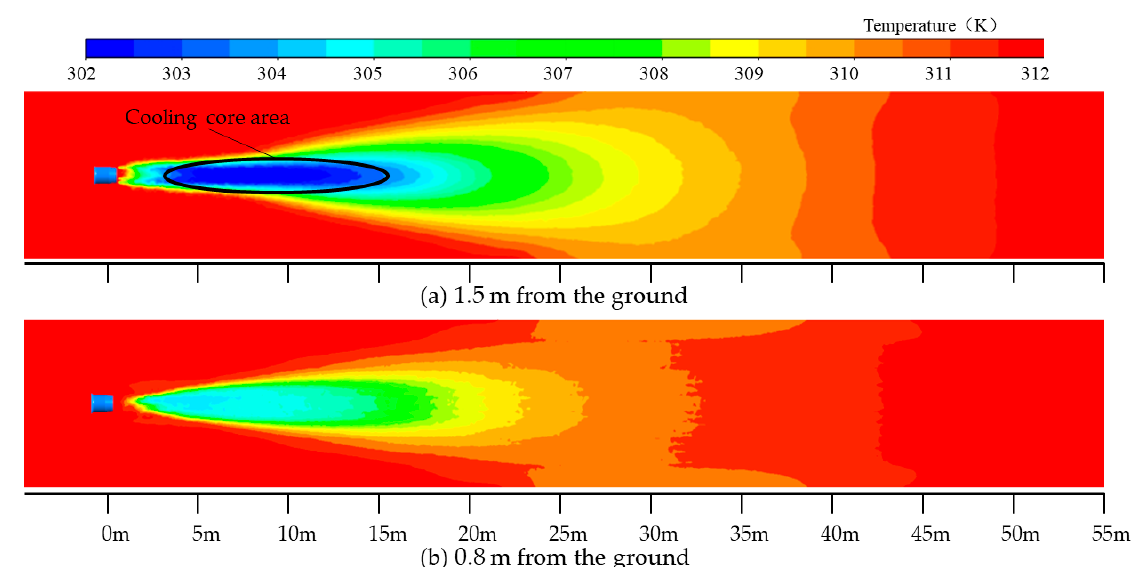
Figure 14. The temperature distribution on the horizontal plane at different heights above the ground. ( a )—Temperature distribution on the horizontal plane 1.5 m above the ground; ( b )—temperature distribution on the horizontal plane 0.8 m above the ground. Table 8. Comparison of simulated and experimental values.